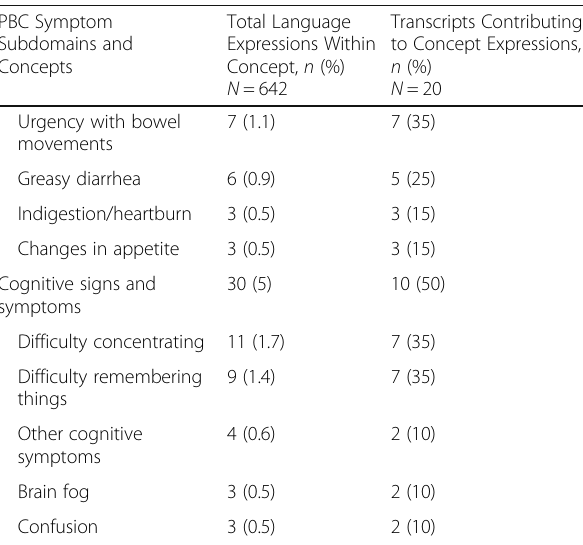
Table 2 Summary of symptom concept code frequency totals